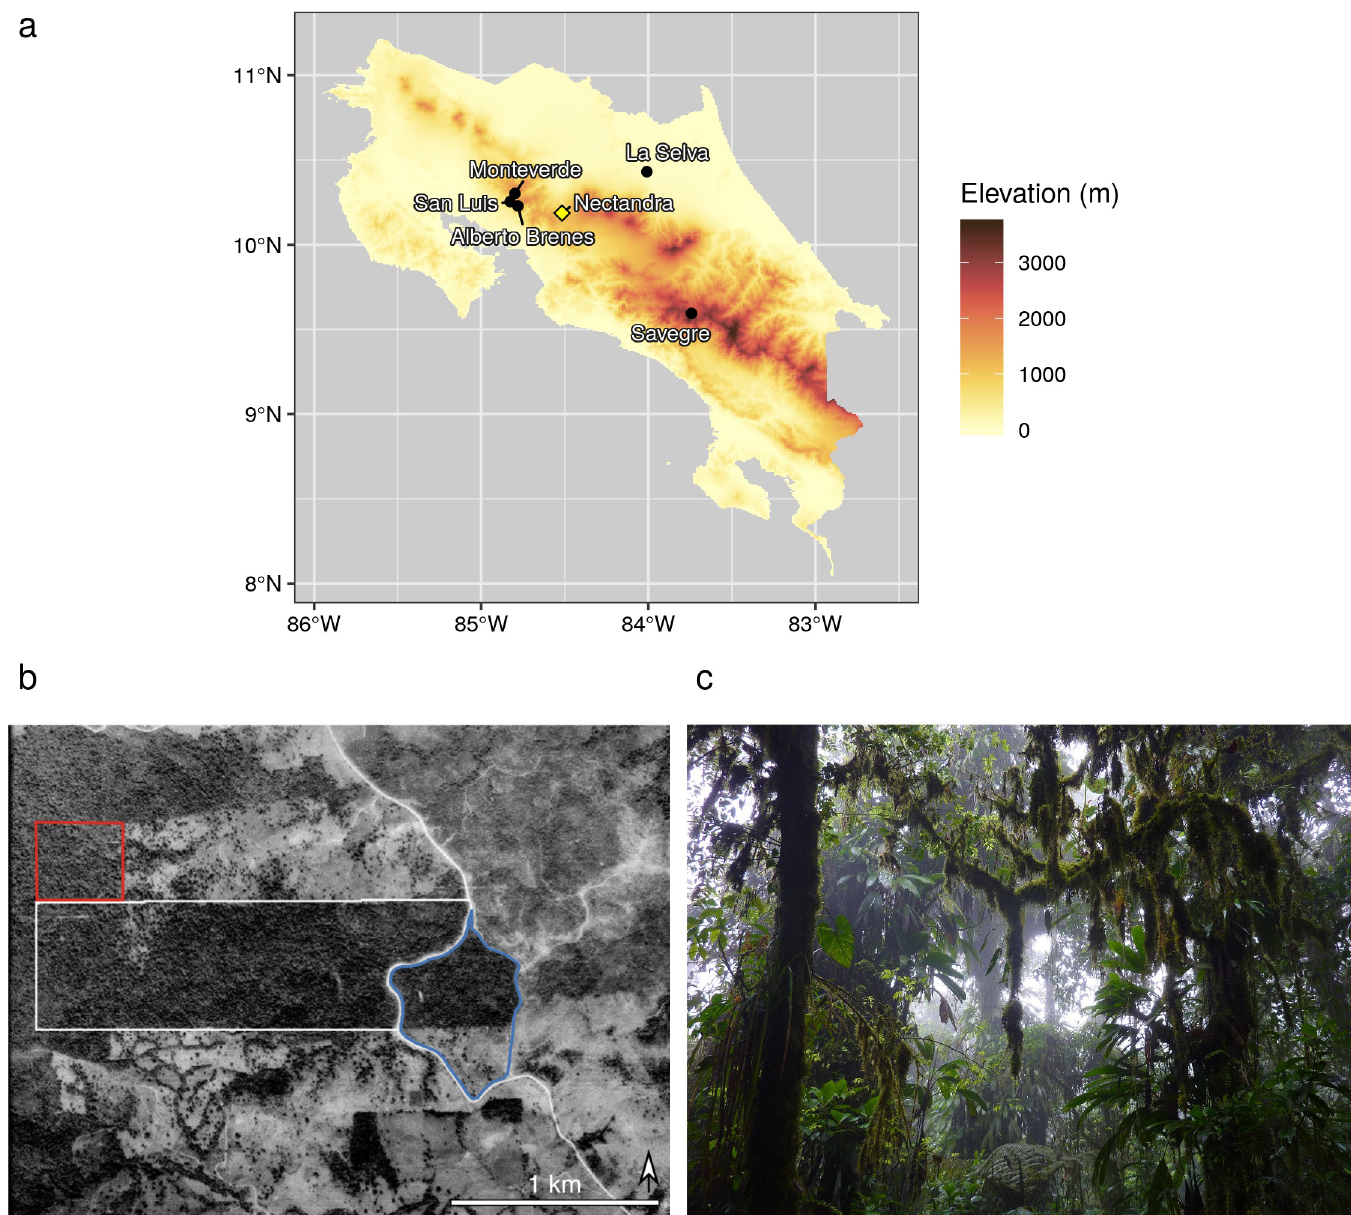
Fig 1. Location of the Nectandra Cloud Forest Reserve (“Nectandra”). (a) Map of Costa Rica showing location of Nectandra (yellow diamond) and other protected areas that have been surveyed for pteridophytes (black dots). Other protected areas include Alberto Manuel Brenes Biological Reserve, La Selva Biological Station, Monteverde Cloud Forest Reserve, San Luis Biological Reserve, and the upper watershed of the Savegre River in the Los Santos Forest Reserve. Elevation data downloaded from the CGIAR SRTM 90m digital elevation database [22] using the getData function in the R package raster [23]. Map created using ggplot2 [24]. (b) Aerial photo of Nectandra ( c . 1992). Nectandra consists of three parcels of land: The original parcel is in white ( c . 80% primary forest), with areas added later in red (“Ocotea” parcel, primary forest) and blue (“Persea” parcel, secondary forest). Note extreme deforestation outside of protected areas. Reprinted under a CC BY license with permission from Instituto Geogra´fico Nacional de Costa Rica, original copyright 1992. (c) Example of interior of primary forest at Nectandra. Photo courtesy of Evelyne Lennette, reprinted under a CC BY license with permission.